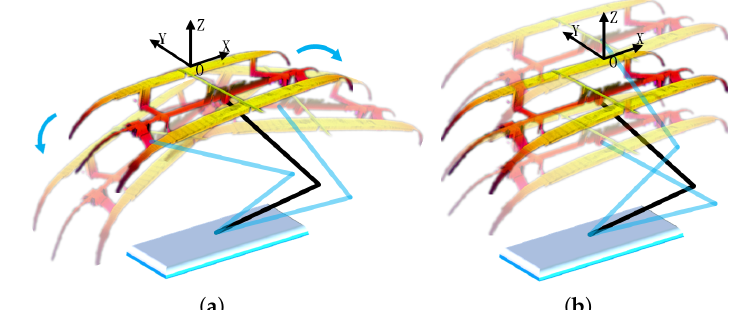
Figure 5. Example of pantograph pose change: ( a ) change in X-O-Z coordinates and ( b ) change in Z